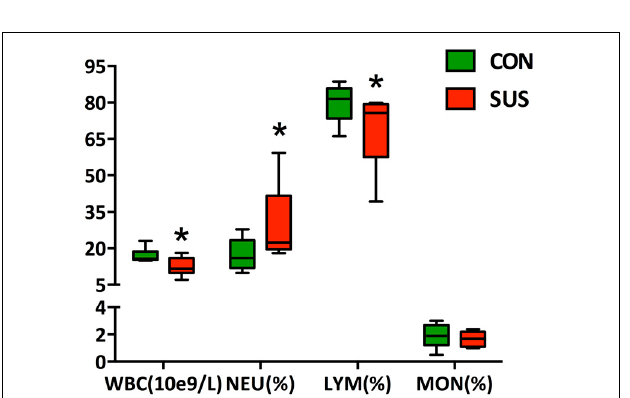
FIGURE 4 | Effects of simulated weightlessness on the concentration of WBC, and the relative percentage of NEU, LYM, and MON in peripheral blood. CON, control group; SUS, simulated weightlessness group. Data are representative as median with absolute range (min. and max.) and interquartile ranges Q25 and Q75. ∗ P < 0.05, compared with the control group. WBC, white blood cells; NEU, neutrophils; LYM, lymphocytes; MON,